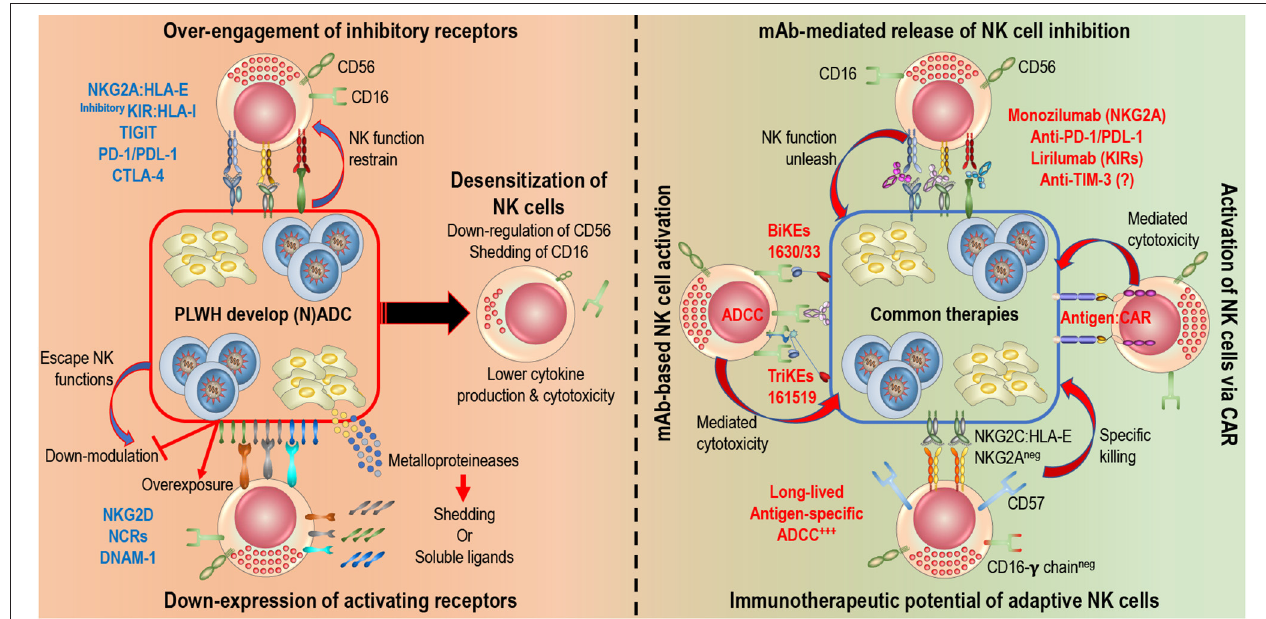
FIGURE 1 | Rescuing and harnessing NK cell potency in PLWH developing cancers. Left : HIV-infected and cancer cells share common NK cell escape mechanisms. 1. Over-engagement of inhibitory receptors (i.e., NKG2A, inhibitory KIRs, PD-1...) blocks killing abilities of NK cells. 2. Down-modulation (blocking expression of ligand or shedding of ligand) or over-exposure (constant expression of ligands or release of soluble ligands) induce down-expression of activating receptors (NKG2D, NCRs, DNAM-1…) on NK cells. Right : Novel immunotherapies are being develop to harness NK cell potency and target HIV-infected and cancer cells. 1. Monoclonal antibodies (mAb) release engagement of inhibitory receptors, unleash NK cell cytotoxicity and engage Fc receptors (CD16) to induce ADCC. Several clinical trials are in progress. 2. Engineered proteins, Bi-specific or Tri-specific Killer engagers (BiKEs or TriKEs) and Chimeric Antigen Receptors (CARs), act as a link between NK cells and target cells to induce cytotoxicity. BiKEs or TriKEs induce ADCC by engaging CD16 receptors and bind to antigen on target cells. 3. Adaptive features of NK cells, defined by a higher expression of CD57, NKG2C, and/or absence of FcR- γ , could be harnessed to elicit specific killing of target